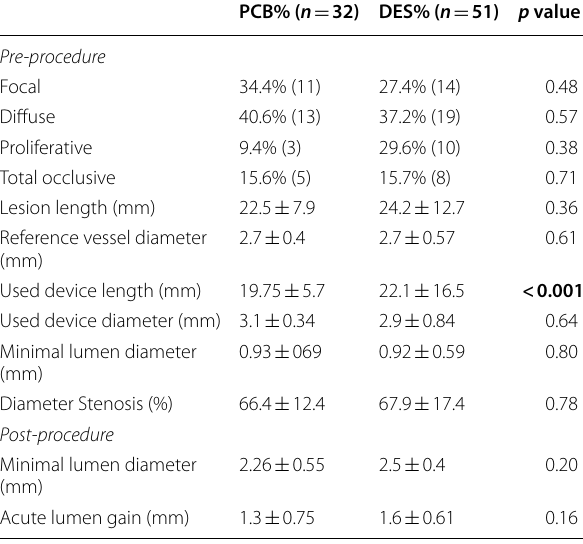
Bold values indicate p value significant (< 0.05) PCB Paclitaxel-coated balloon, DES Drug-eluting